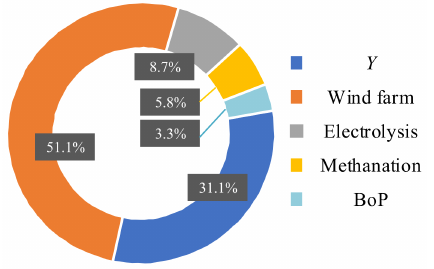
Figure 7. Total net revenue as well as the sum of investment cost and operational cost for WTGs, electrolysis, methanation, and BoP